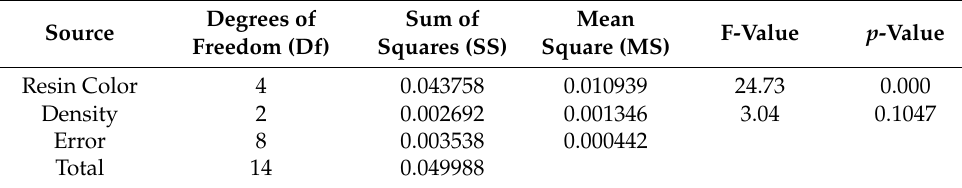
Table 10. Analysis of variance for